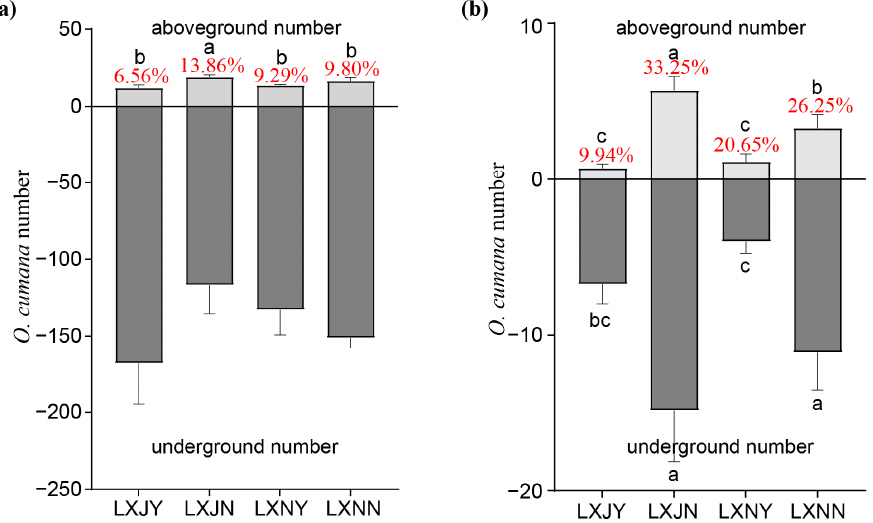
Figure 3. Effects of D74 agents and maize rotation on O. cumana parasitism in the first ( a ) and second ( b ) year. The red numbers represent the unearthed rate, different letters indicate significant differences between the groups (uncorrected Fisher’s LSD, p < 0.05).